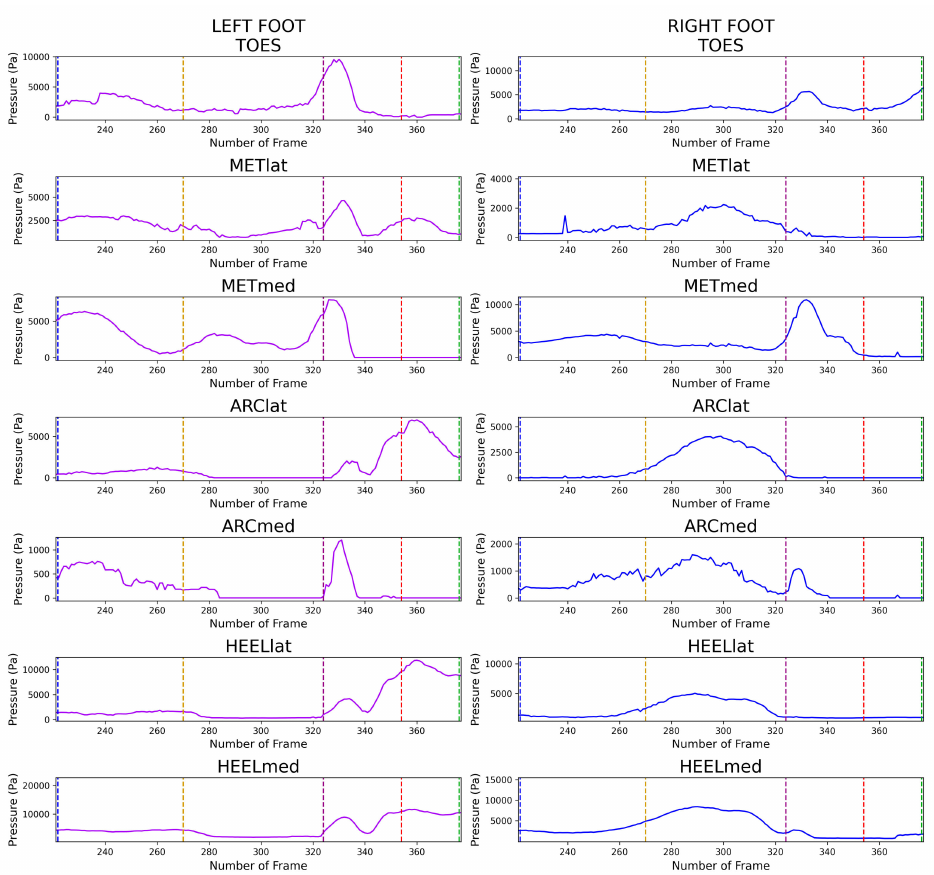
Figure 4. Pressure variation in time frames recorded for a professional player using a driver club in each of the 7 anatomical areas. Pressures plots on the left side belong to the left foot, whereas the pressure plots on the right side represents the right foot. Dashed lines show the key instants during the swing (blue: stand (ST), yellow: middle back swing (MB), purple: top back swing (TB), red: impact (IM), and green: finish